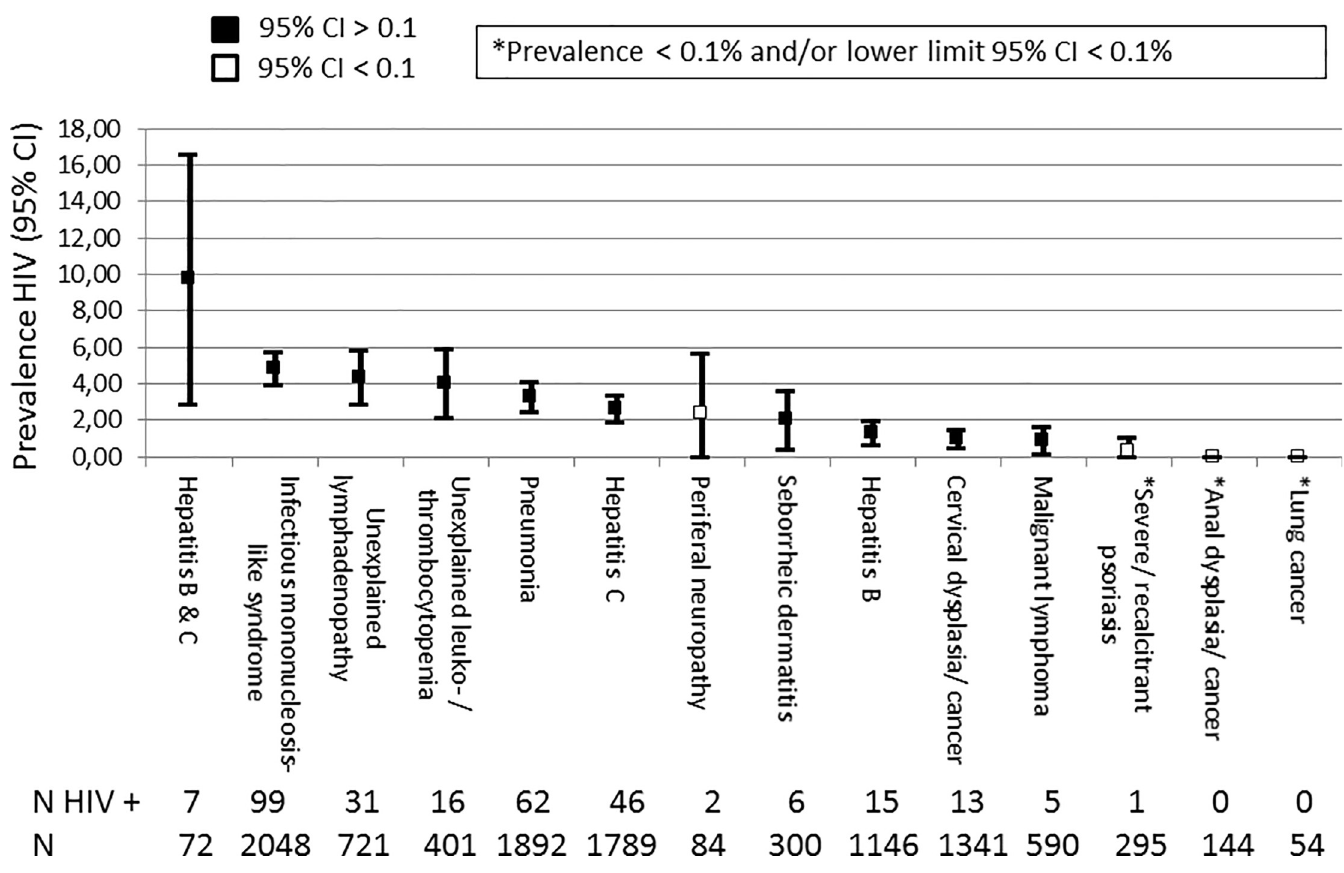
Fig 1. Prevalence of testing HIV positive: HIDES II study.